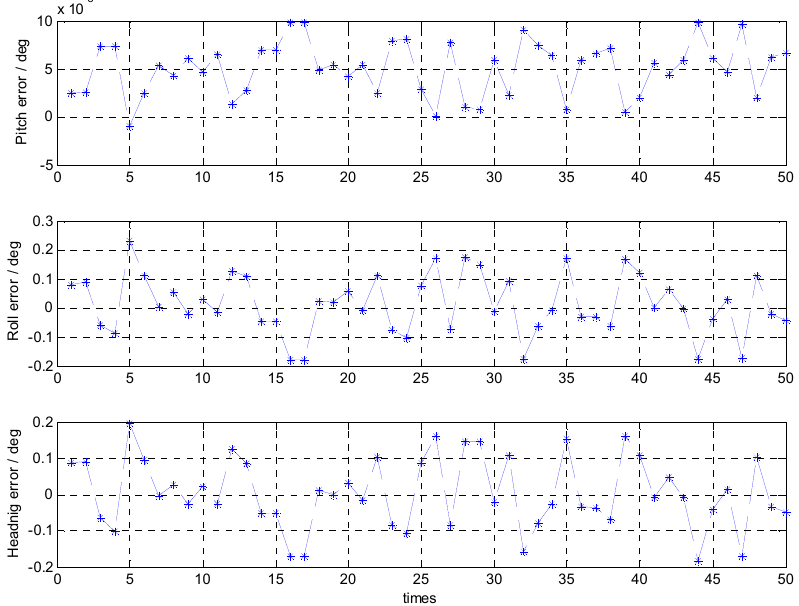
Figure 4. Attitude errors of the coarse alignment with the calm sea condition. Table 1. Statistical analyses of the attitude errors with the calm sea condition. Heading Error ( ◦